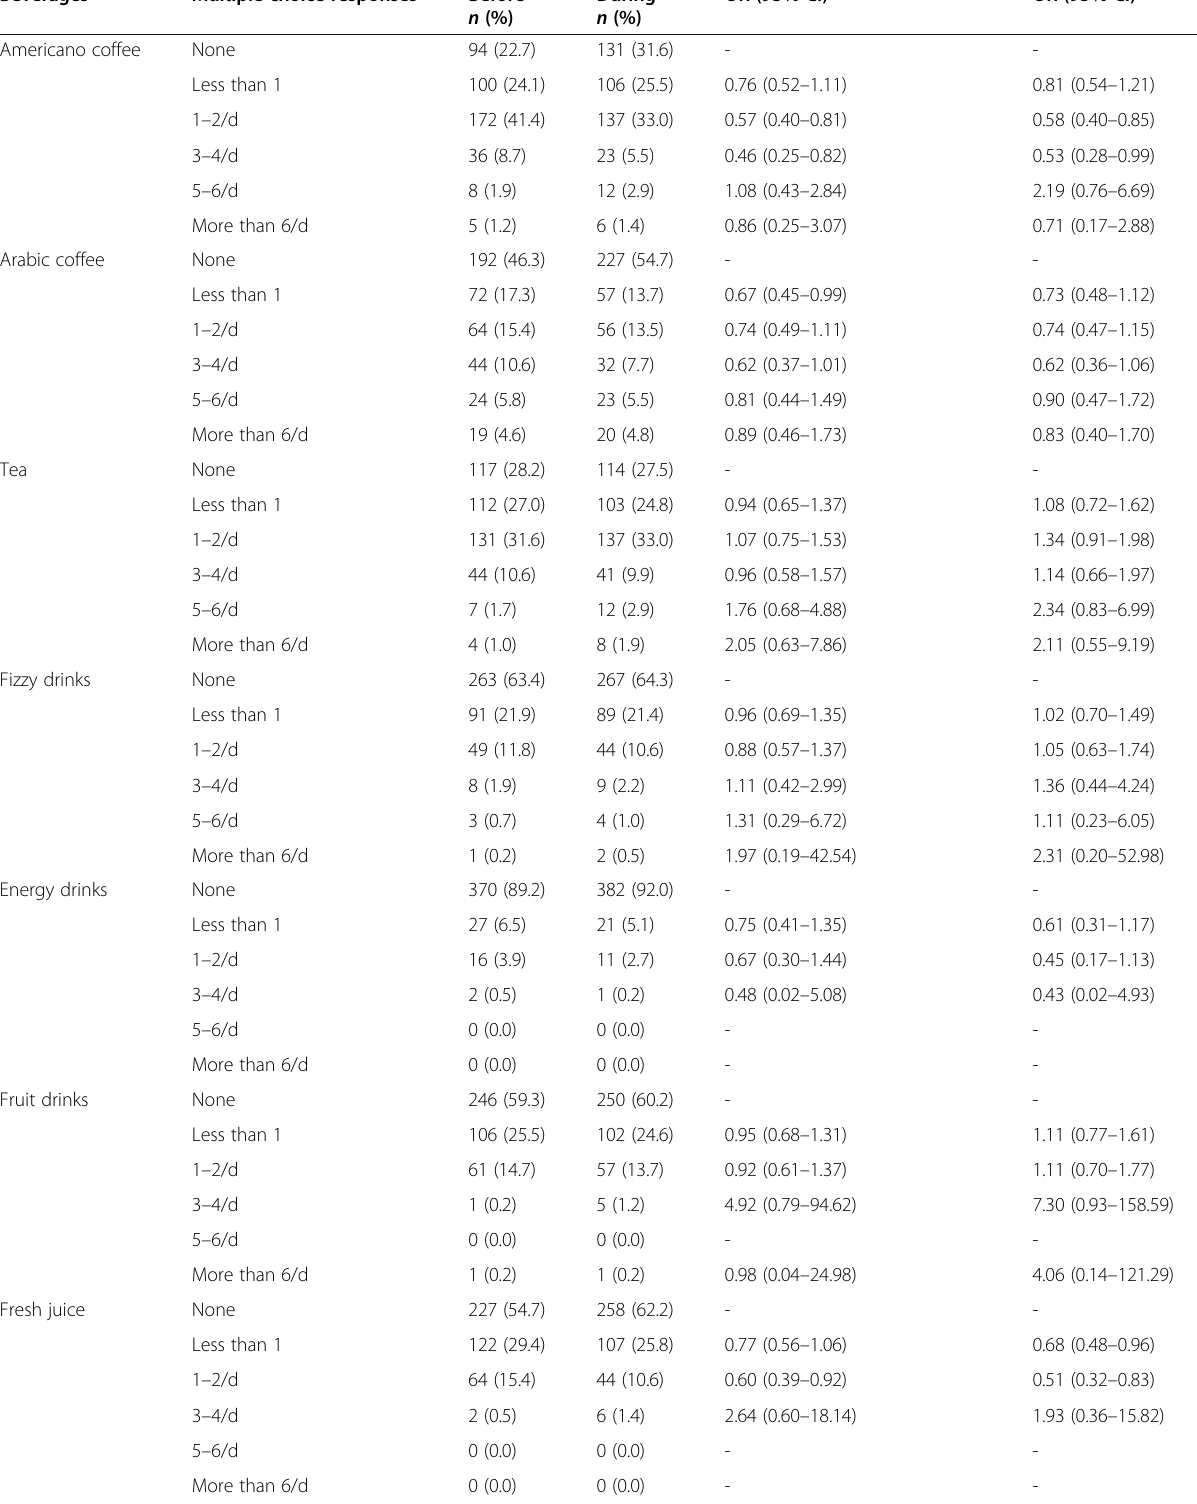
Table 4 Multivariate analysis between two periods using logistic regression for beverage consumption